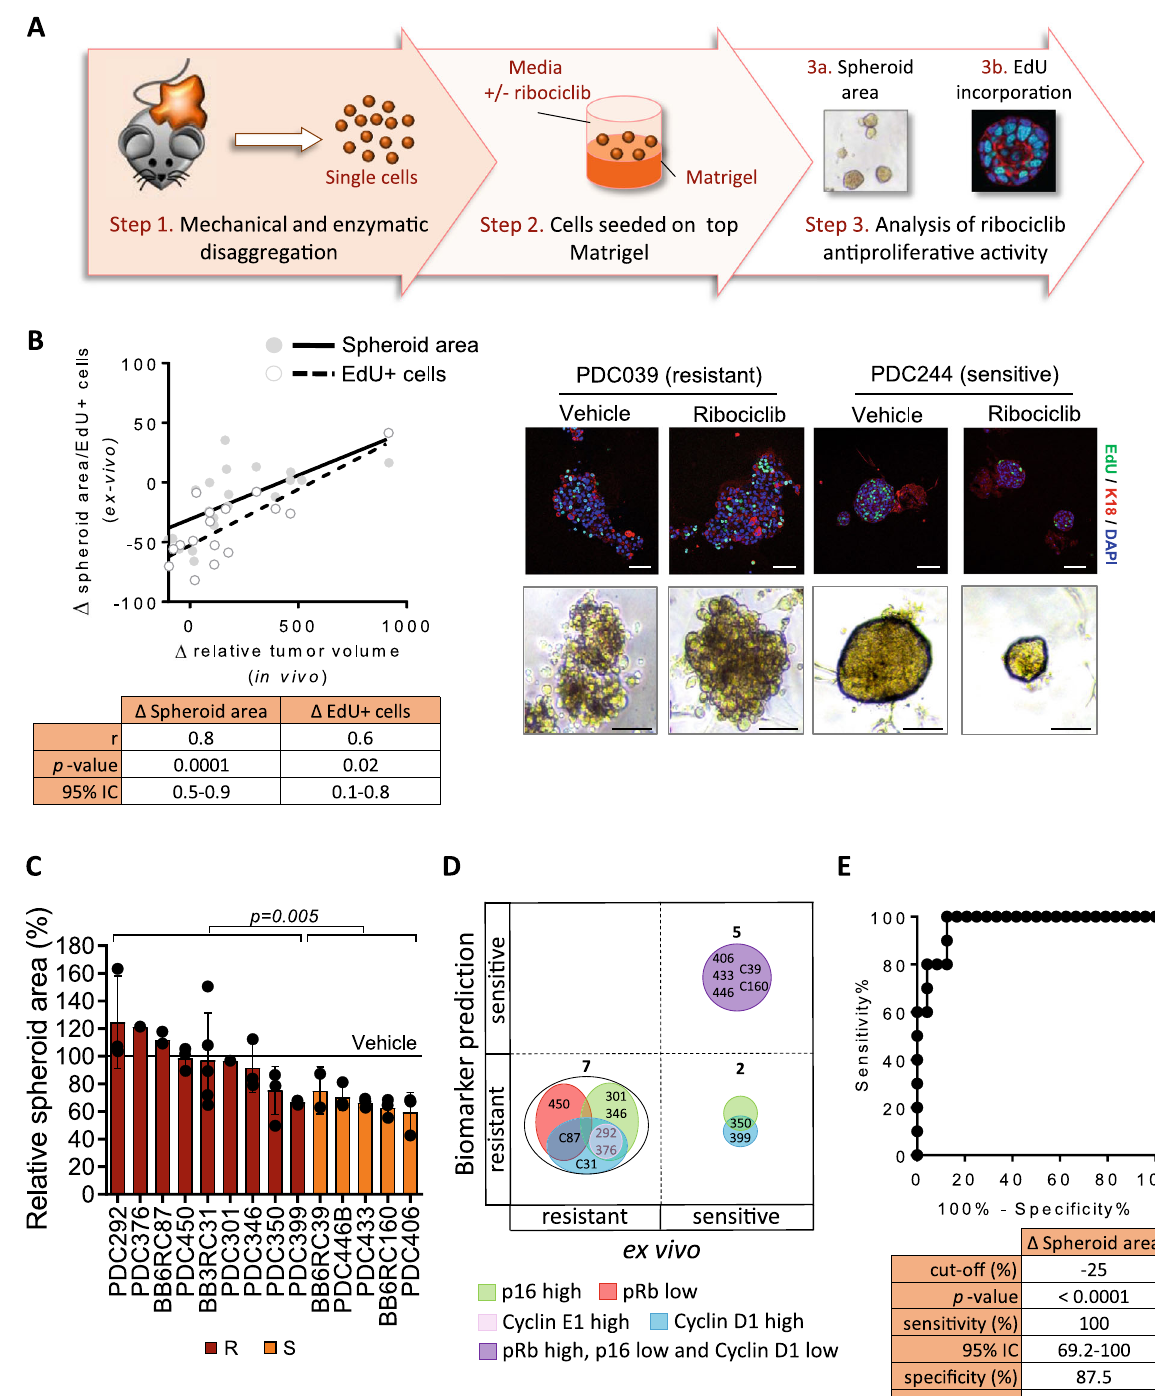
Fig. 3 | Biomarker validationin short-term patient-derivedtumorcells (PDCs). A Work fl ow depicting the generation of BC PDCs short-term ex vivo cultures from PDXs and the subsequent analysis of ribociclib response using two different read- outs. B Correlation analysis of the ex vivo response of PDCs ( y -axis) vs. the in vivo response of the corresponding PDXs ( x -axis), measured as change in spheroid area (open dots) or the change in EdU incorporation ( fi lled dots) after ribociclib treat- ment. The Spearman ’ s coef fi cient (r), two-tailed p -value and 95% of con fi dence interval(95% CI)foreachread-outaresummarizedbelowthe graph.Representative images of one ribociclib-resistant (PDC039) and one ribociclib-sensitive (PDC244) model treated with vehicle or ribociclib are shown on the right panel, namely EdU/ K18 staining by confocal microscopy and organoid size by bright fi eld microscopy. EdU is shown in green, cytokeratin 18 (K18) in red and DAPI in blue. Scale bar =